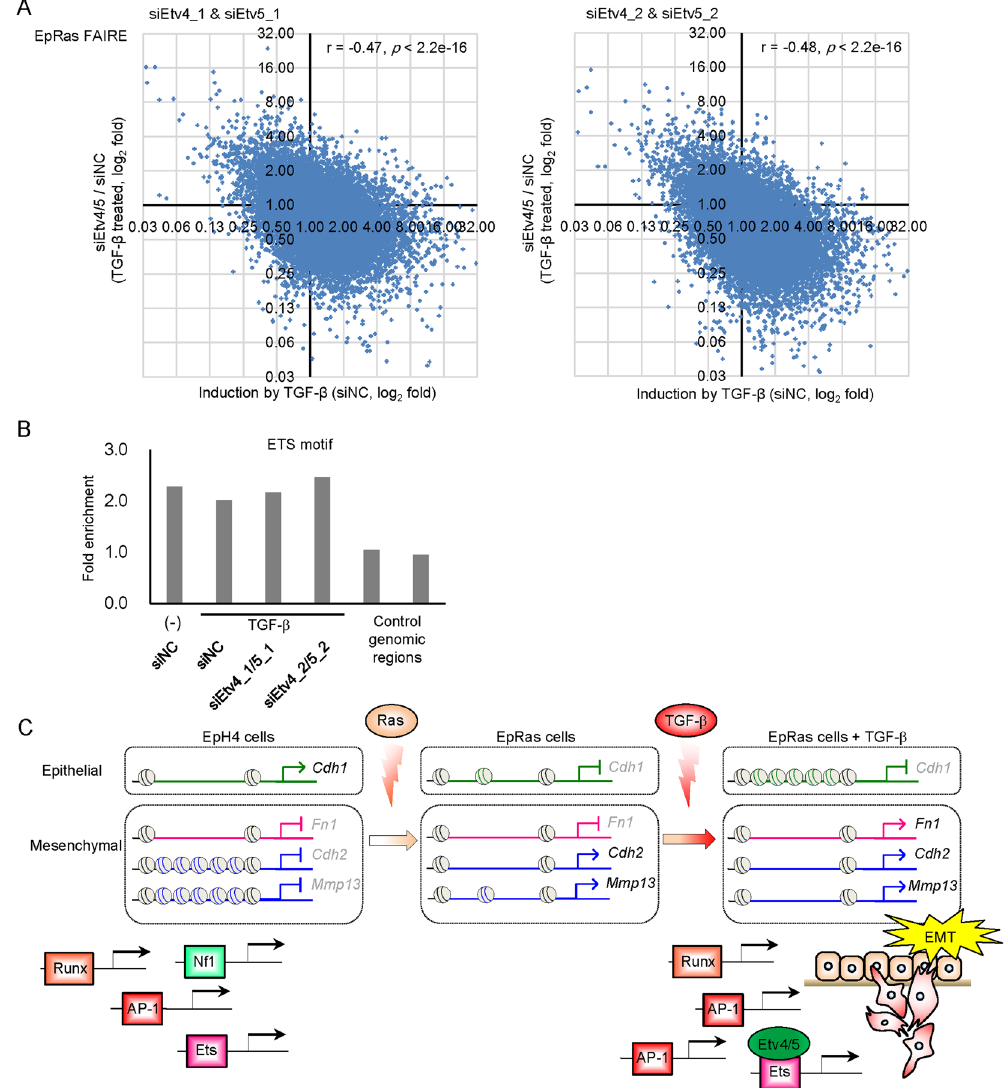
Figure 7. Effect of Etv4/5 siRNAs on the global chromatin accessibility. ( A ) Scatter plots showing the effect of TGF- β (X-axis) and Etv4/5 siRNAs (Y-axis) on the genome-wide chromatin accessibility determined by FAIRE-seq. Note that there was a significant correlation between the effect of two different siRNA sets (r = 0.51, p < 2.2e-16, Supplementary Fig. S7). ( B ) Enrichment of ETS binding motif in the FAIRE-positive regions of EpRas cells treated by TGF- β and siRNAs as indicated. ( C ) A schematic model for regulation of EMT-related gene expression through the differential expression of transcription factors and alteration of chromatin accessibility. In the process of EMT, chromatins are gradually closed by Ras and TGF- β at the Cdh1 /E-cadherin gene locus. In contrast, upregulated genes are regulated by a variety of mechanisms. The Fn1 /fibronectin gene locus is open irrespective of Ras and TGF- β treatment, while Cdh2 /N-cadherin gene locus becomes accessible upon Ras transformation, and the Mmp13 gene locus becomes accessible upon Ras transformation and TGF- β stimulation. Differentially expressed transcription factors, Etv4 and Etv5, are responsible for a subset of EMT- related changes in gene expression partially through the alteration of chromatin